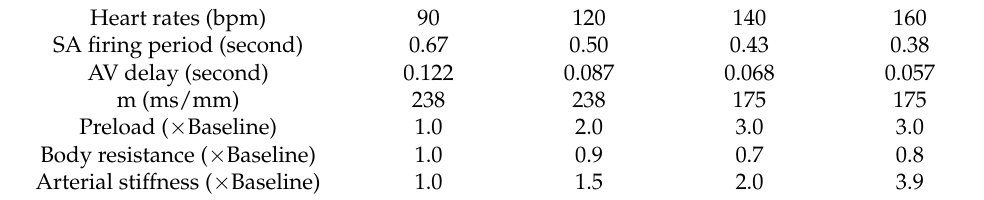
Table 2. Adjustment to LHHM model inputs to study increased heart rate during exercise.